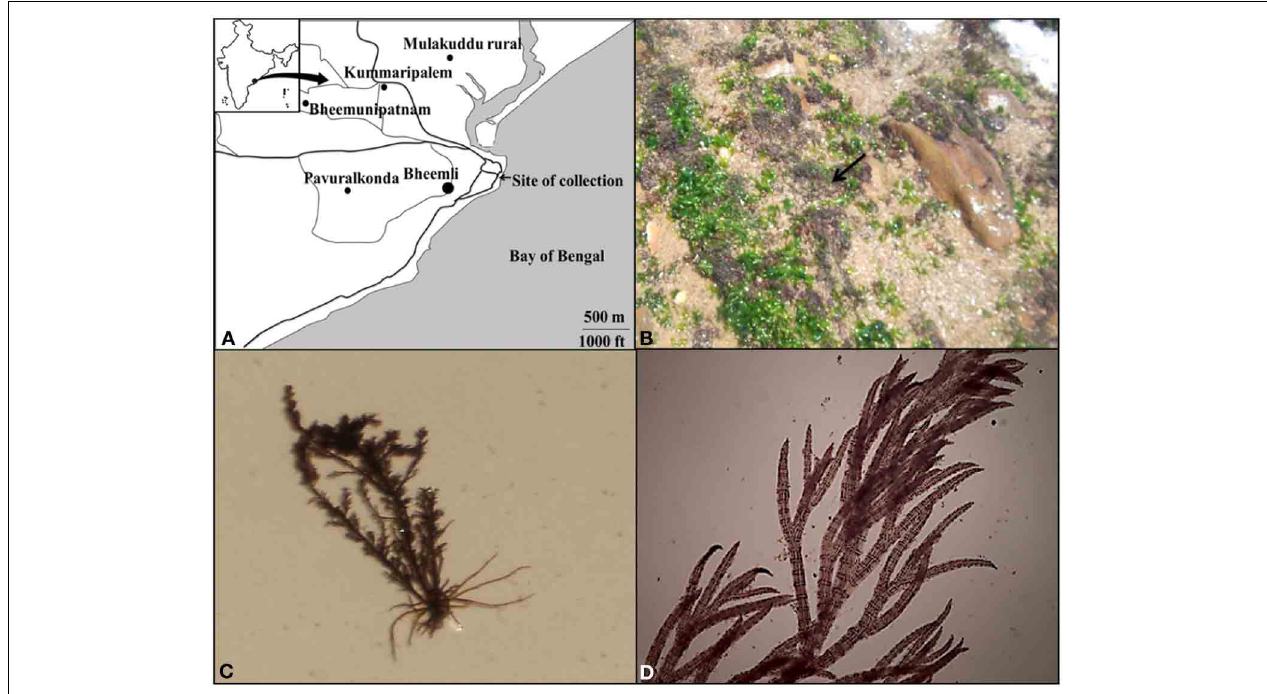
FIGURE 1 | Map of sampling area (Bheemli beach, Vishakhapatnam, Andhra Pradesh, India) (A), Aerial view of red brown algal mat of Bryocladia sp. on rock surface (arrow) (B), Morphology (C), and microscopic view of the collected alga (D).